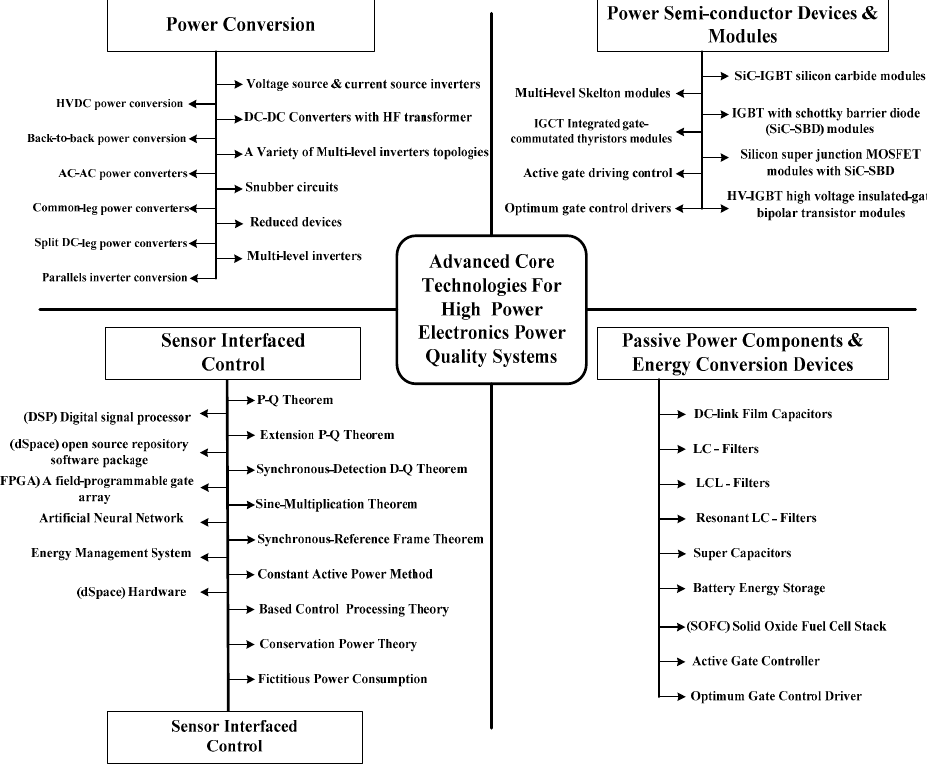
Figure 12. Overview of advanced core technologies for power quality systems of high-power electronics.